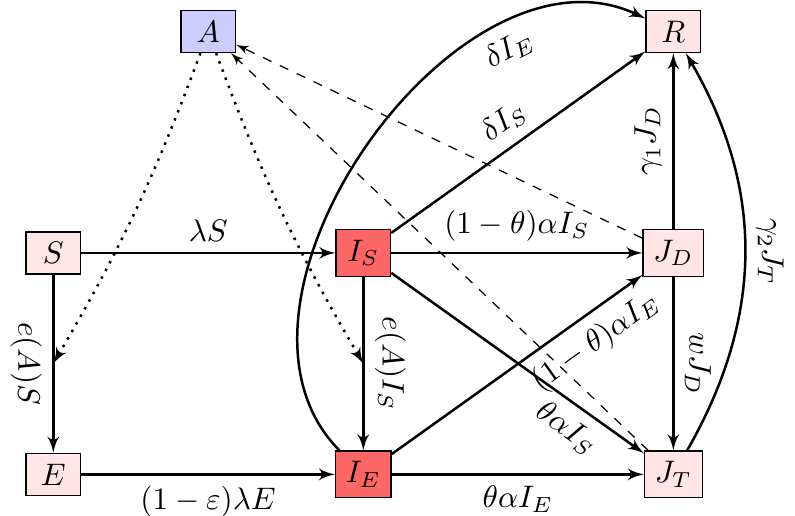
Fig. 1: Flow diagram of the model. Dark red compartments are infectious, blue represents awareness. Plain arcs are flows of individuals between compartments, dashed lines indicate the influence of compartments on A , dotted lines show the flows on which A acts.